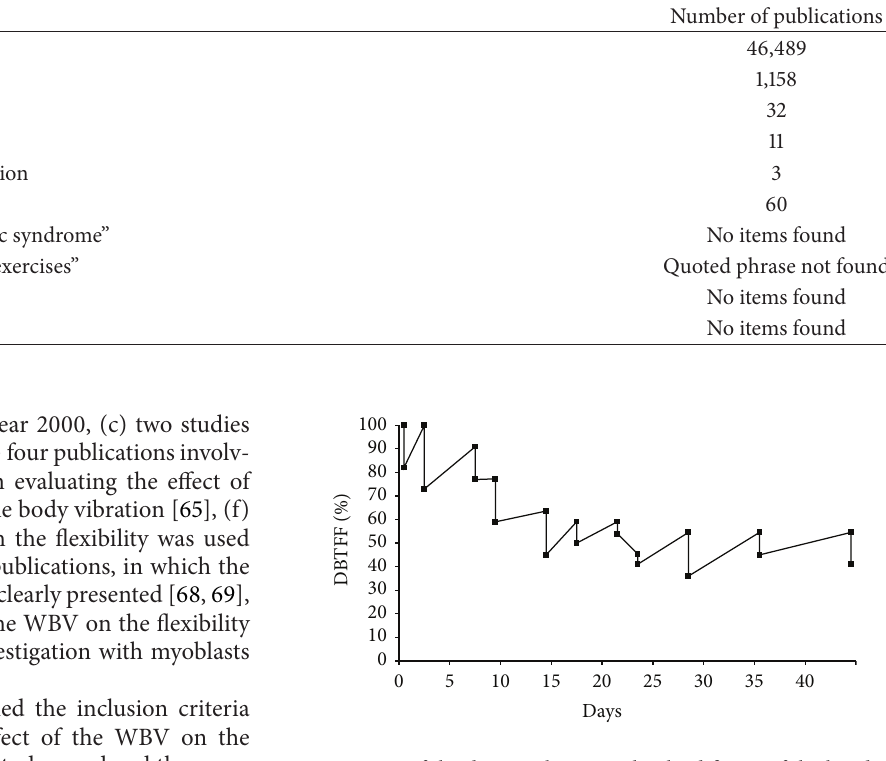
Figure 1: % of the distance between the third finger of the hand of the patient and the floor (DBTFF) in sessions in various